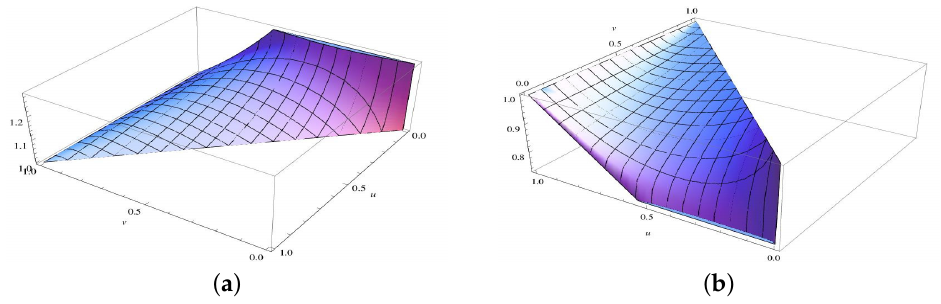
Figure 1. Surface of ratio C θ ( u , v ) / C θ ( v , u ) . ( a ) 0 ≤ u ≤ v ≤ 1; ( b ) 0 ≤ v ≤ u ≤ 1.